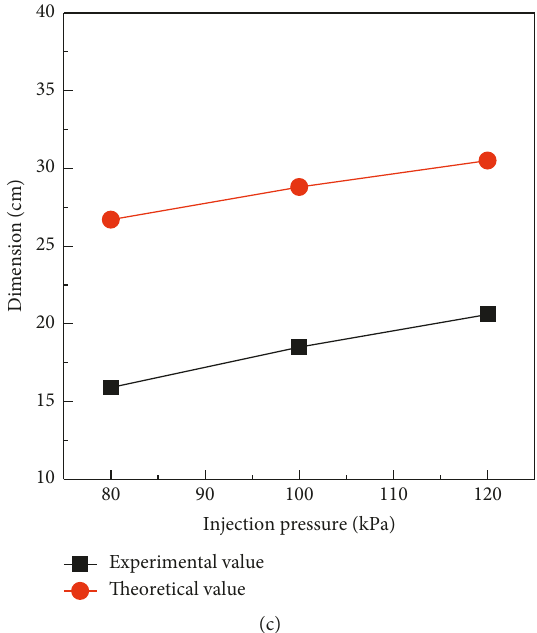
Figure 11: The longitudinal dimension of grout concretion under different ( w / c )